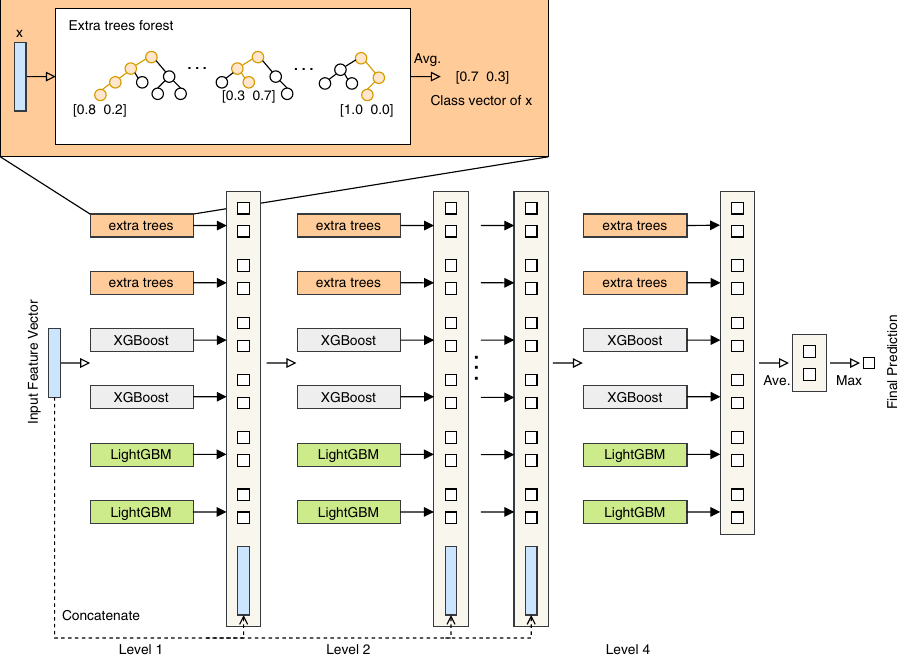
Figure 2. Illustration of the cascade forest structure of DF-COVID-19